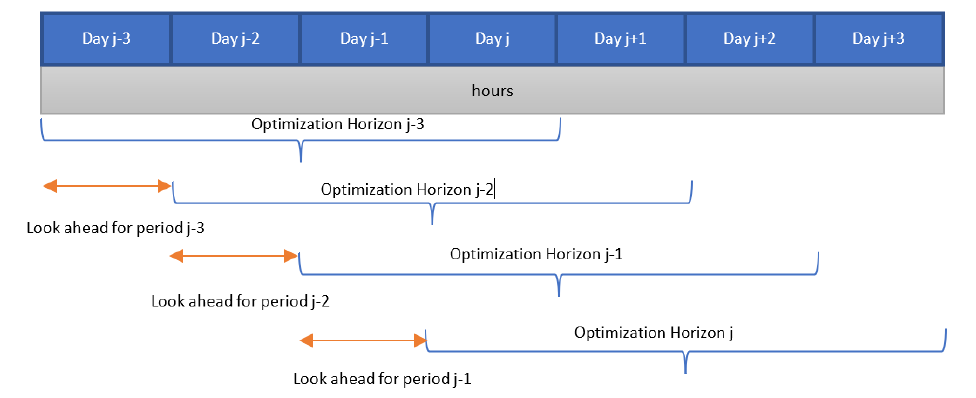
Figure 1. Time horizons of the optimization with the look-ahead period